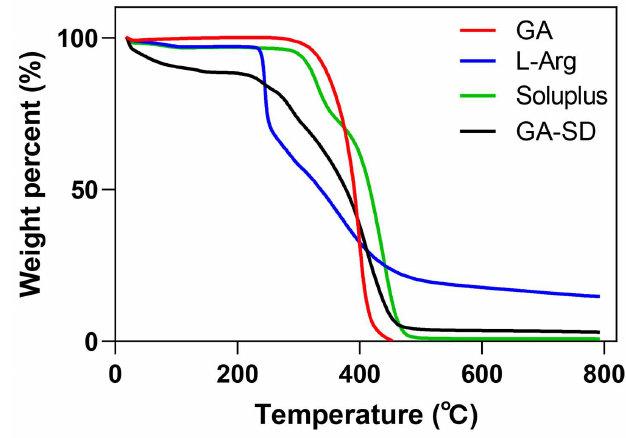
Figure 4. TGA curves of the mass loss as a function of temperature.